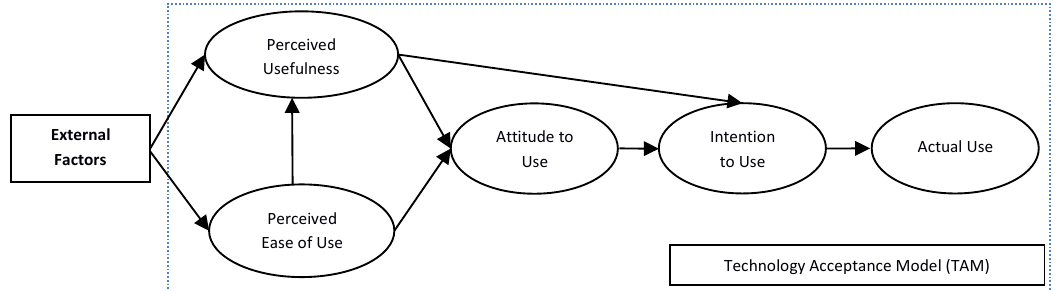
Figure 1. Original TAM constructs (Davis et al.,